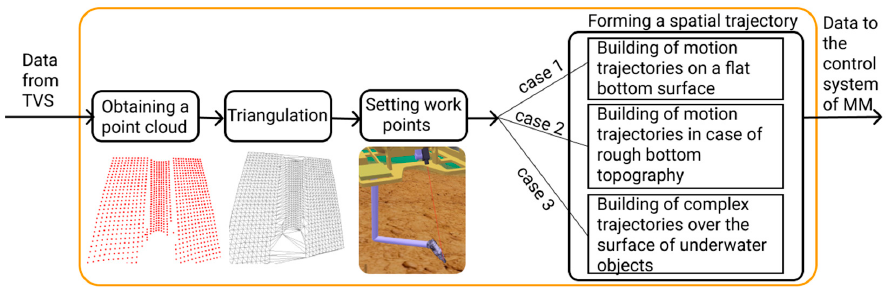
Figure 2. The steps of the method.